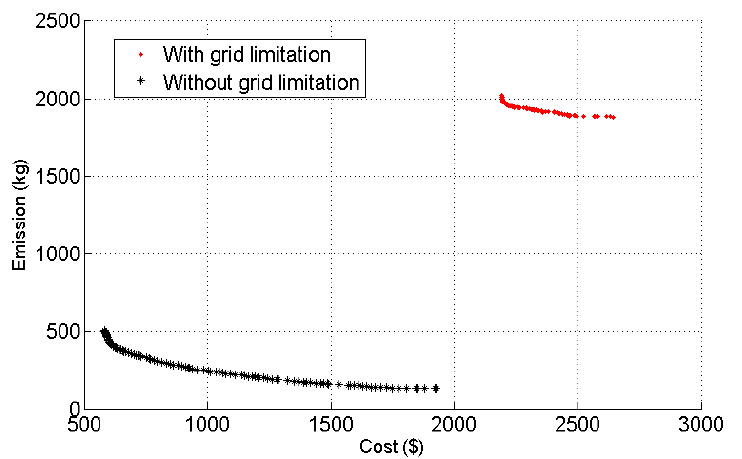
Figure 10. Comparison of Pareto Fronts with and without limitation of upstream grid exchange (cost and emission based).